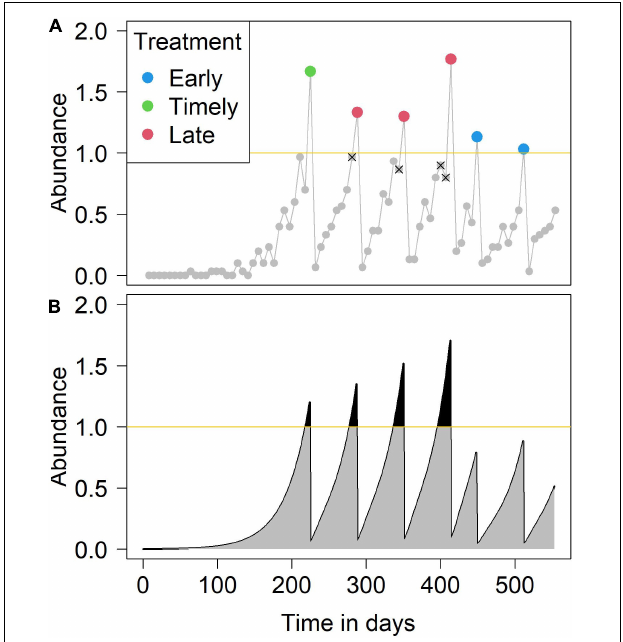
FIGURE 1 | An example simulation of (A) the monitored sea lice abundance and (B) the true sea lice abundance over a production cycle. In panel (A) , the points indicate weekly sampling events. Over-estimation of abundance results in an early treatment (blue points), while under-estimation of abundance results in late treatment (red points). Points annotated with an x represent a necessary but unexecuted treatment due to under-estimation. In panel (B) , the gray areas plus the black areas represent IB (infestation burden), while the black areas represent IB over threshold. In this example simulation, the number of fish per sampling event was 30 and the treatment threshold was one (yellow line) adult female sea